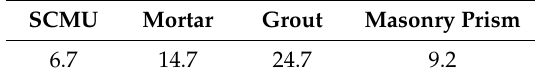
Table 2. Average compressive strength of masonry materials (N/mm 2